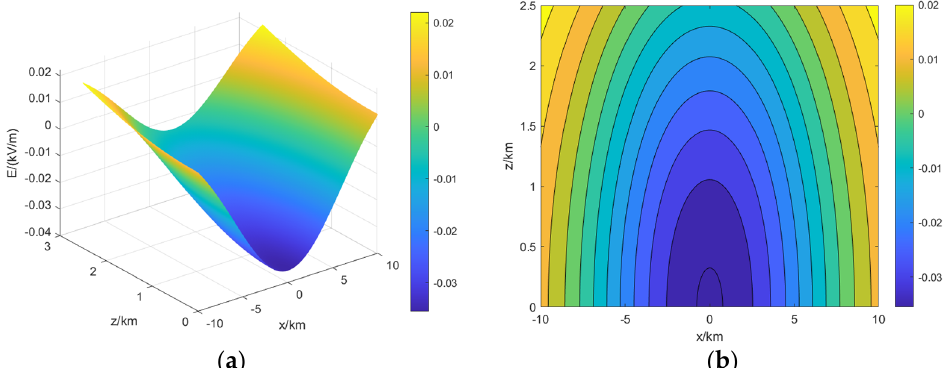
Figure 8. ( a ) Electric field distribution on the longitudinal section while y = 16 km. ( b ) Contour of potential distribution on the longitudinal section while y = 16 km.